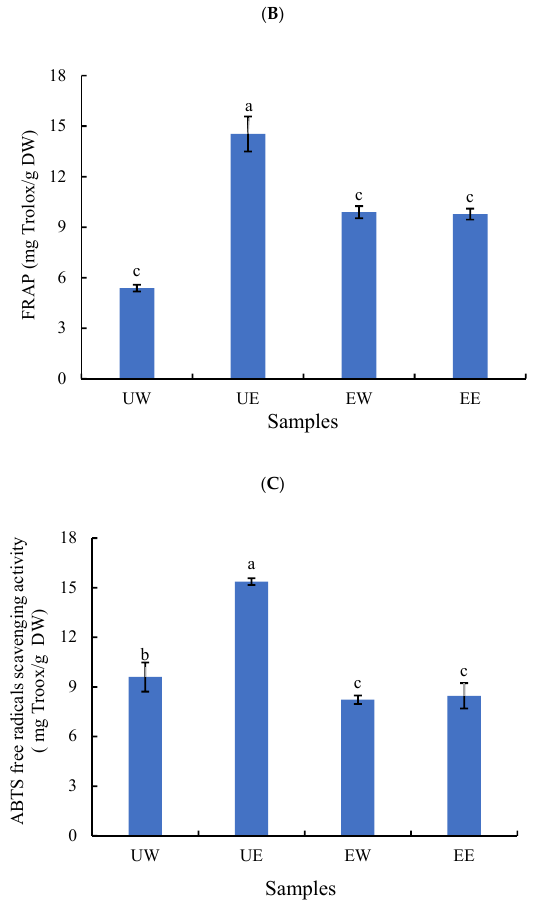
Figure 2. The determination of the three antioxidant indices in the four different extracts. ( A ) DPPH free radicals scavenging activity, ( B ) FRAP value, and ( C ) ABTS free radicals scavenging activity. Different letters represent significant differences according to Duncan’s test ( p < 0.05). UW = ultrasound-assisted water extract, UE = ultrasound-assisted ethanol extract, EW = enzymatic-assisted water extract, EE = enzymatic-assisted ethanol extract.